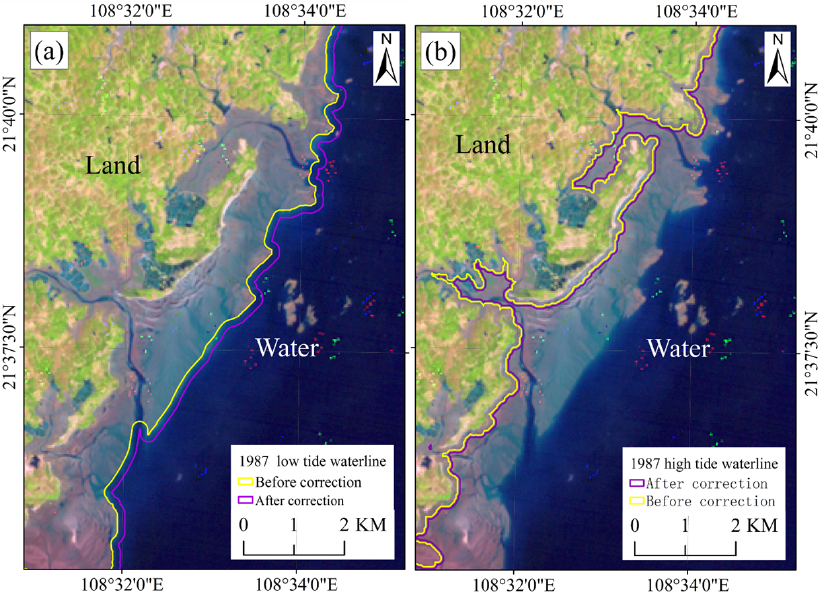
Figure 5. Comparison of before and after correction of tide level in 1987. ( a ) Before and after correction of tide level at low tide. ( b ) Before and after correction of tide level at high tide.